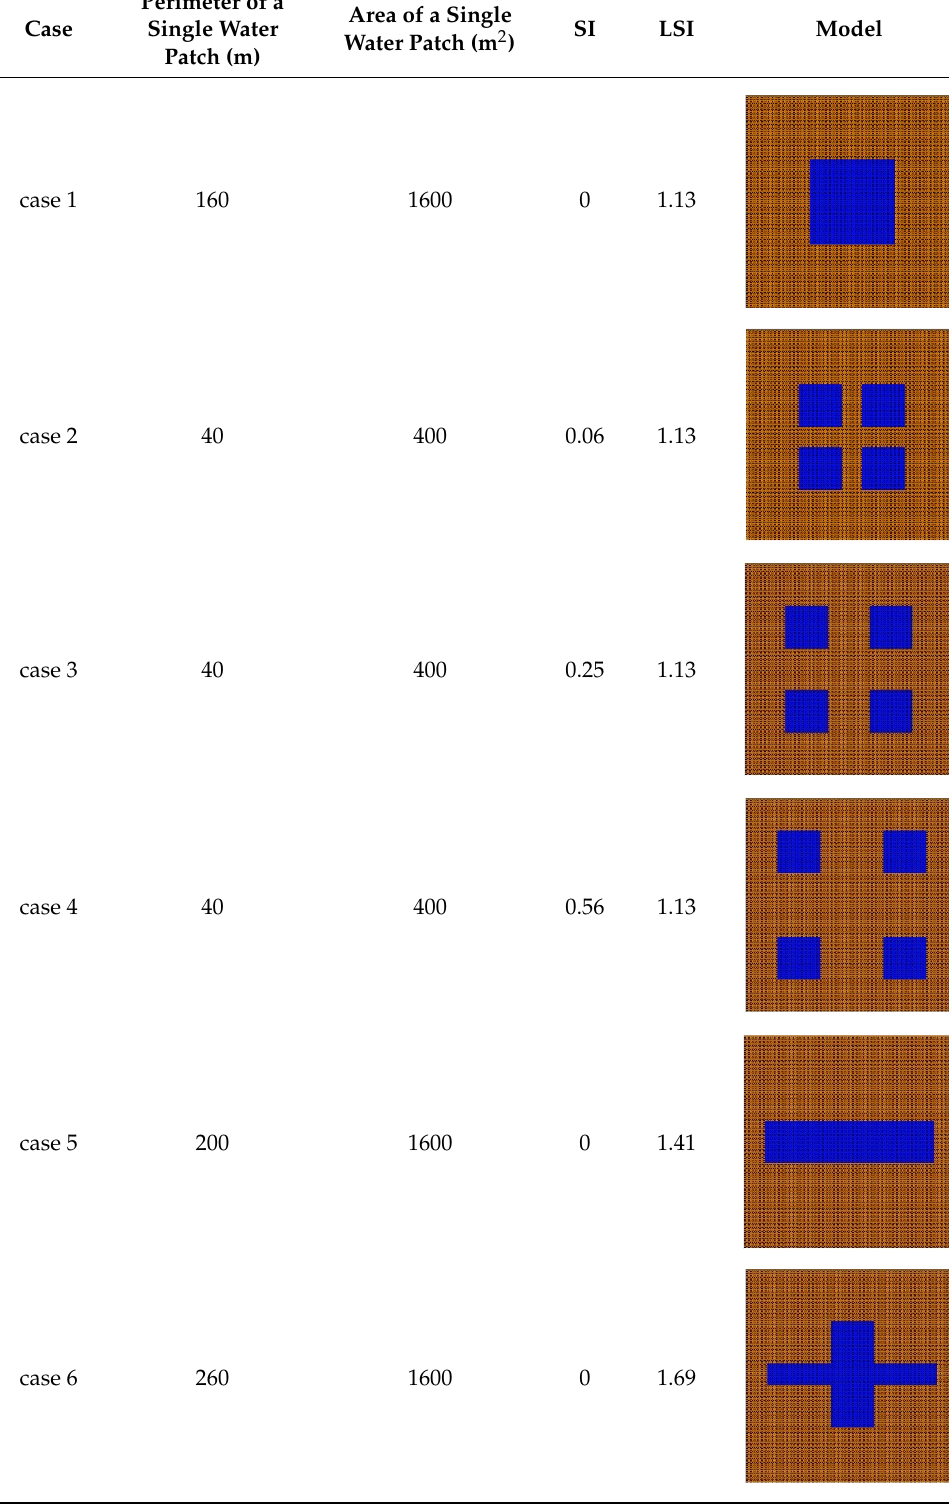
Table 2. Different water body layout model settings.